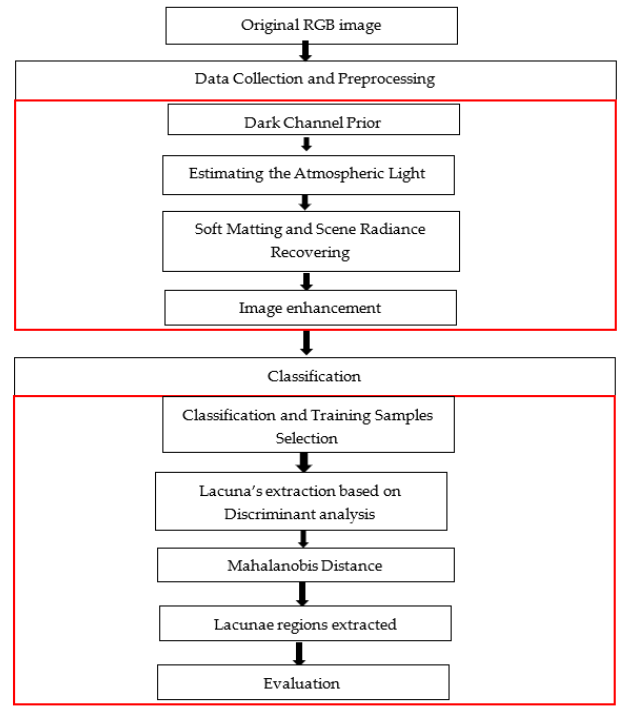
Figure 3. The overall workflow diagram of the proposed approach.